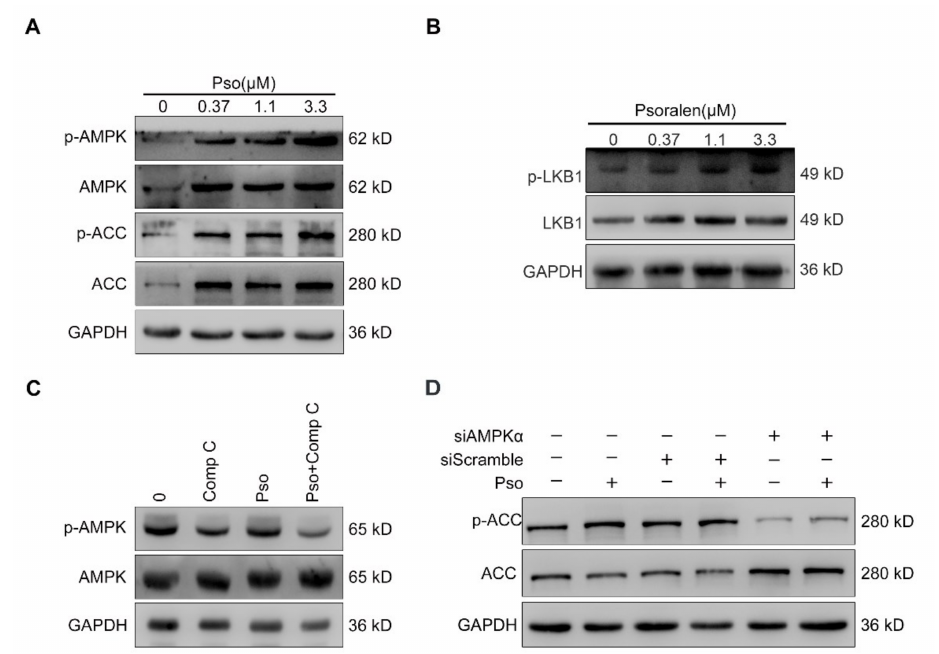
Figure 7. Psoralen activates the AMPK/ACC pathway by activating AMPK. ( A ) L02 cells were induced with sodium oleate (100 µ M) for 24 h and treated with psoralen at 0.37, 1.1, and 3.3 µ M for 24 h. The expression of AMPK, p-AMPK, ACC, and p-ACC was detected by Western blotting. ( B ) The expression of LKB1 and p-LKB1 was detected by Western blotting. ( C ) Sodium oleate-induced L02 cells were treated with psoralen (3.3 µ M) alone or in combination with compound C (10 µ M) for 24 h. The expression of AMPK and p-AMPK was determined by Western blotting. ( D ) L02 cells were transfected with siAMPK α or scramble, induced with sodium oleate (100 µ M) for 24 h, and treated with psoralen (3.3 µ M) for 24 h. The expression of ACC and p-ACC was measured by Western blotting. Abbreviations: AMPK, adenosine 5 (cid:48) -monophosphate (AMP)-activated protein kinase; ACC, acetyl-CoA carboxylase; Comp C, compound C; Pso, psoralen; FASN, fatty acid